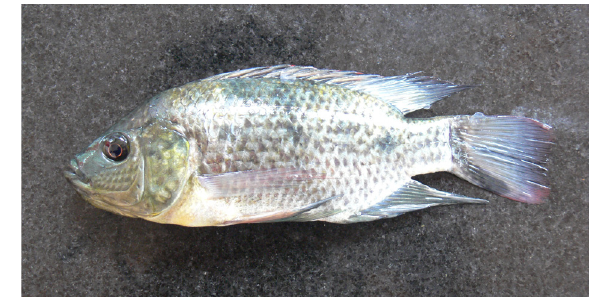
Image 18. Oreochromis